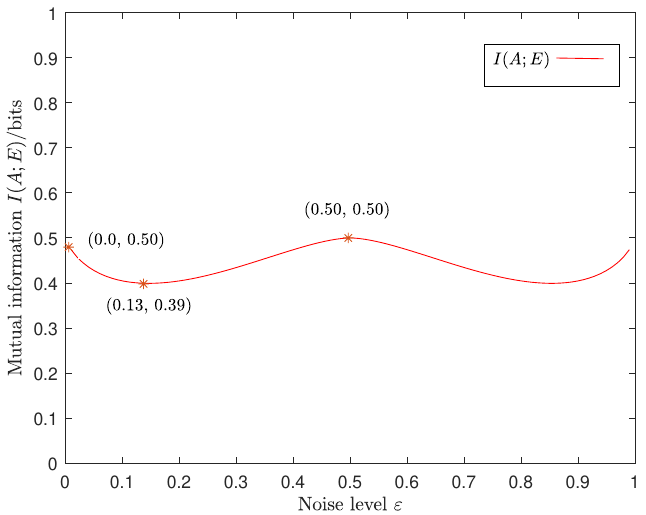
Figure 3. Variation of the mutual information between Alice and Eve I(A:E) as a function of the collective-rotation noise ε